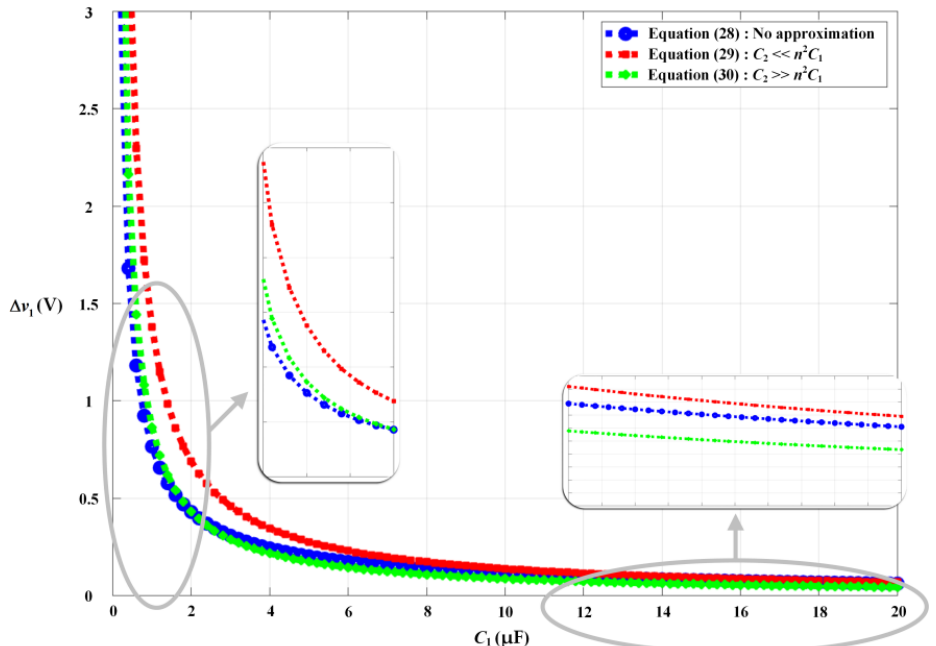
Figure 8. Δ v 1 according to C 1 design. Figure 8. ∆ v 1 according to C 1